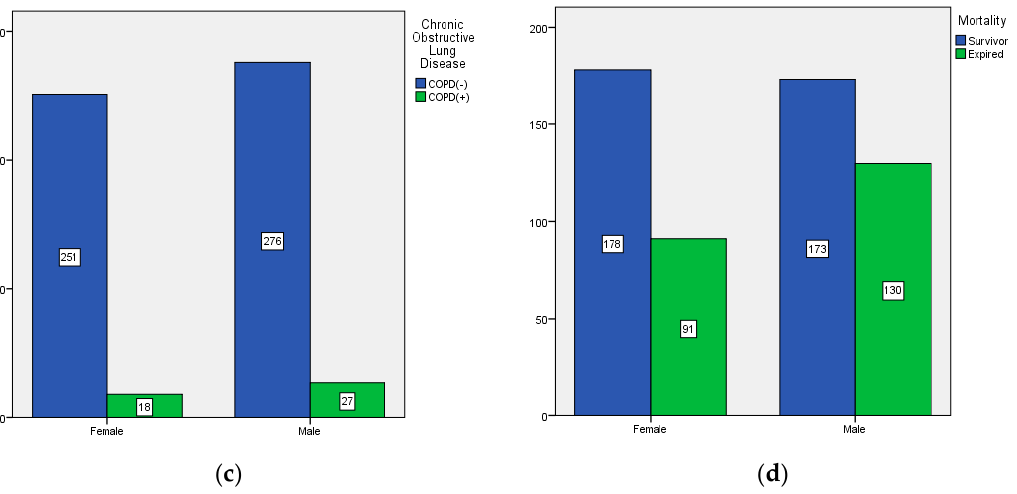
Figure 6. Differentiating survived and expired COVID-19 patients: ( a ) ICU admission, ( b ) chronic obstructive lung disease, ( c ) chronic kidney disease, ( d ) mortality rate.